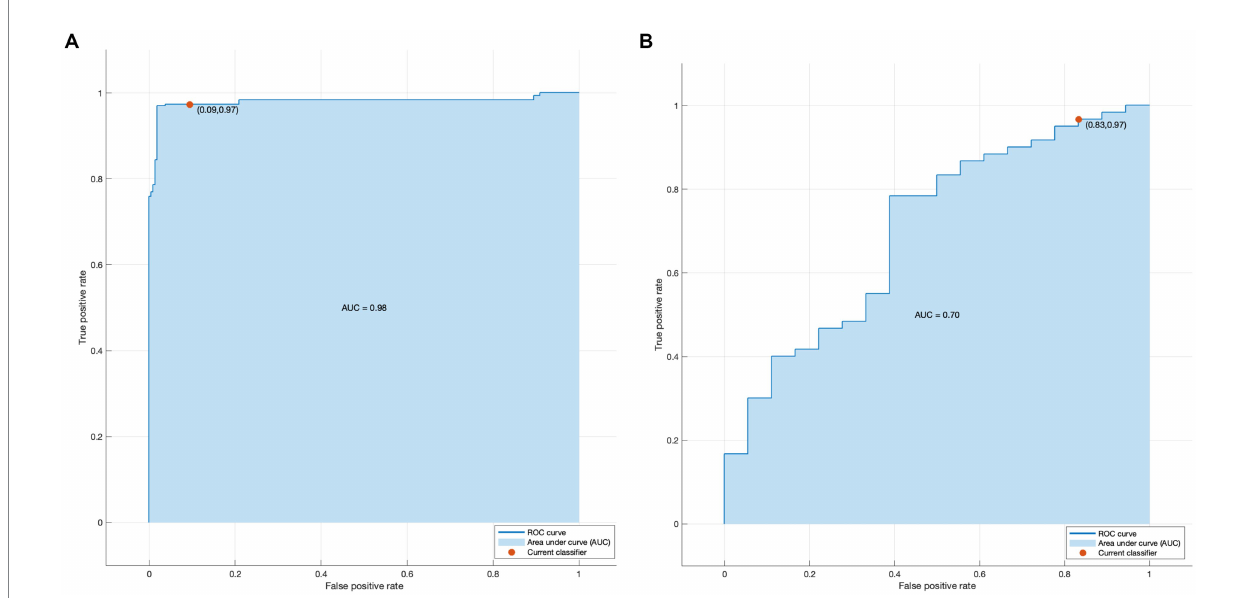
FIGURE 4 (A) Receiver operator characteristic curve for the training set (B) Receiver operator characteristic curve for the test